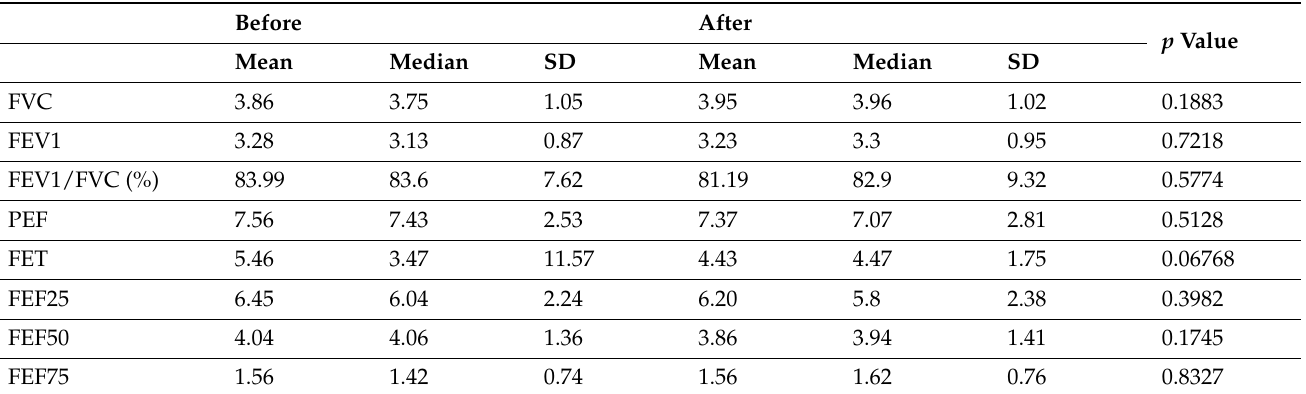
Table 8. Results of spirometry examination of the surgical mask using the Wilcoxon signed-rank test. A p value < 0.05 was considered statistically significant. Statistically significant results are shown in bold. Statistically significant results are shown in bold.